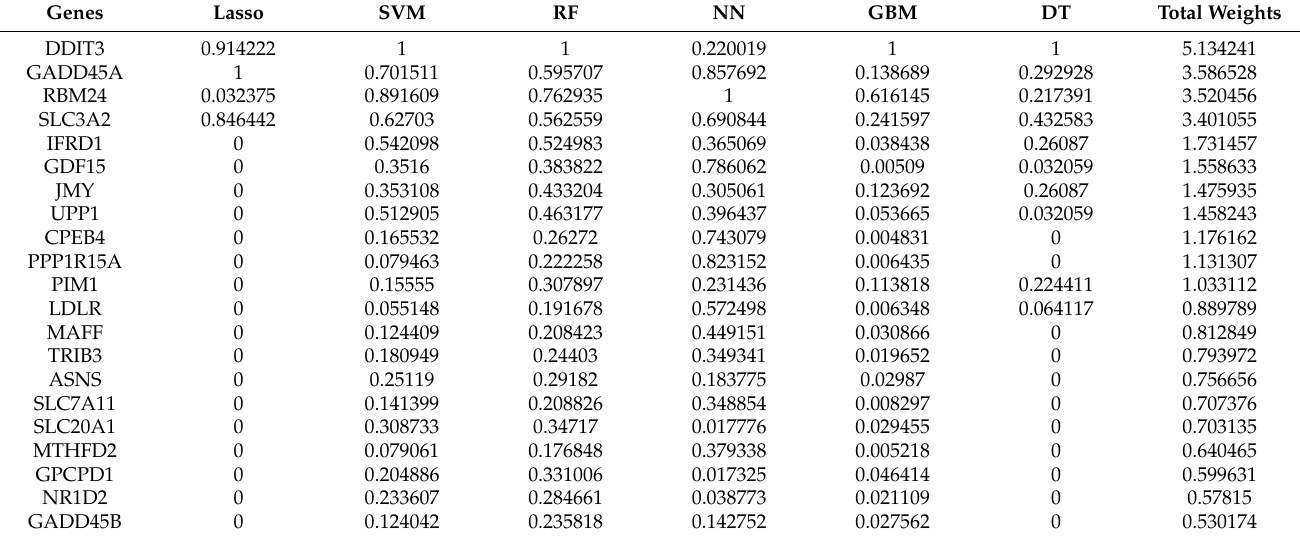
Table 2. The summation of the normalized weights of the six